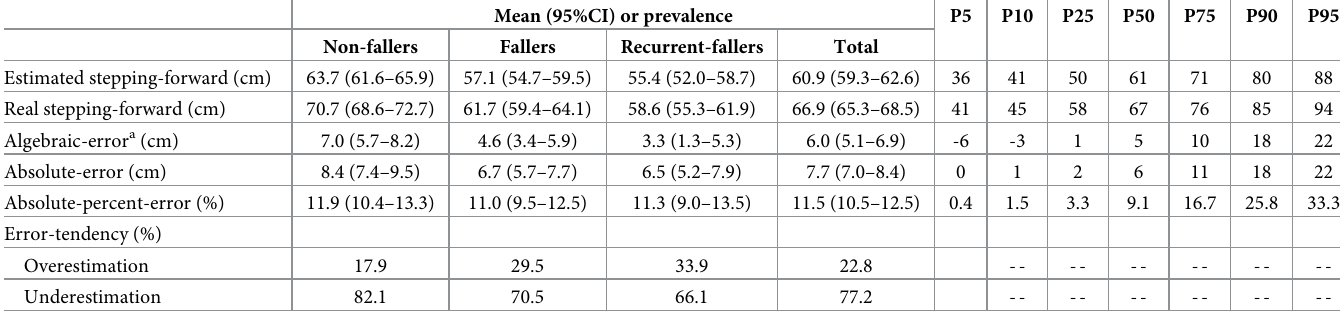
Table 1. Description of participants SF-APT outcomes